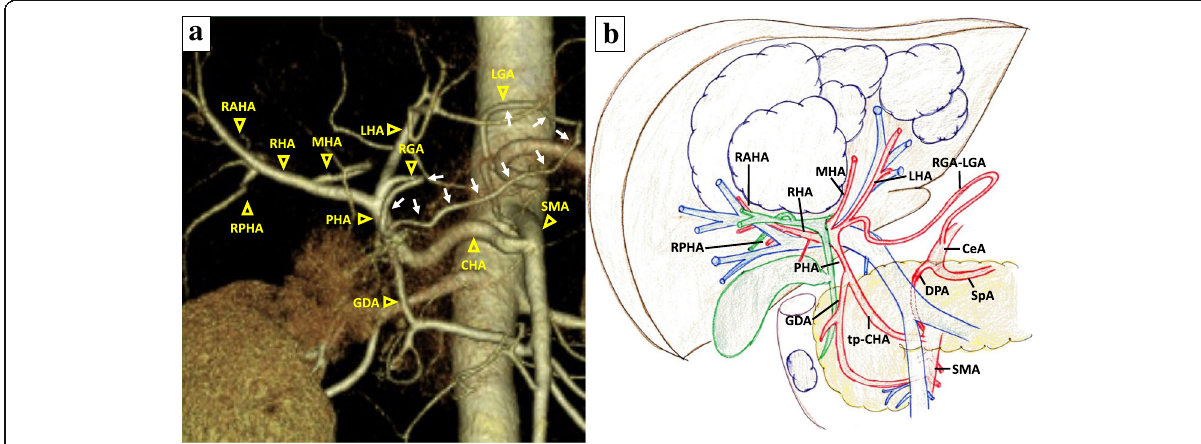
Fig. 2 a A preoperative three-dimensional CT angiogram. The gastric arterial arcade is shown (white arrows). b A preoperative schematic illustration. LGA left gastric artery, RGA right gastric artery, GDA gastroduodenal artery, PHA proper hepatic artery, LHA left hepatic artery, MHA middle hepatic artery, RHA right hepatic artery, RAHA right anterior hepatic artery, RPHA right posterior hepatic artery, CeA celiac artery, SpA splenic artery, DPA dorsal pancreatic artery, tp-CHA transpancreatic